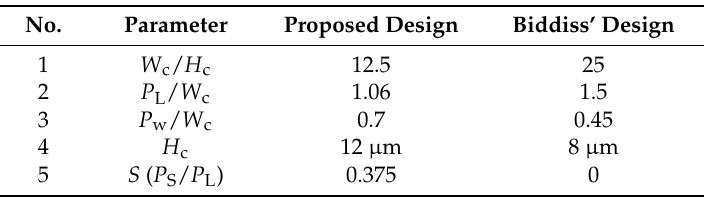
Figure 18. Comparison of normalized concentration distributions at centerline along the channel length between the proposed micromixer and the micromixer reported by Biddiss [8] at E = 280 V/cm. Table 2. Dimensions of the micromixer designs.